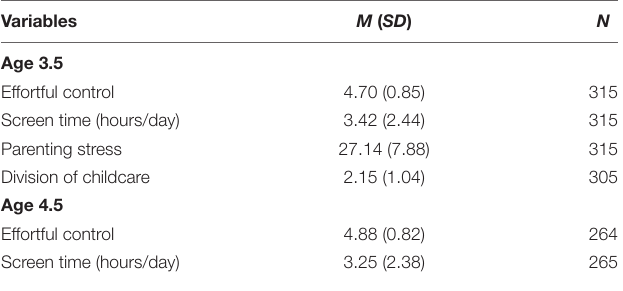
TABLE 1 | Descriptive statistics for continuous study